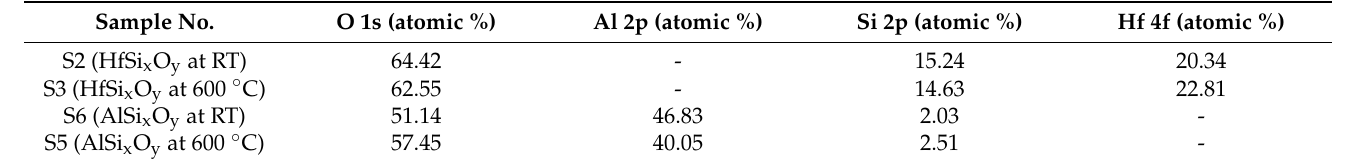
Table 2. Composition of silicates layers obtained by PLD at different temperatures. Sample